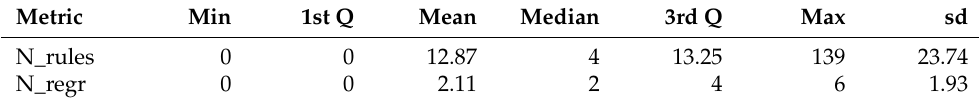
Table 6. Descriptive statistics for rules and regressors in the experiment runs with synthetic data.